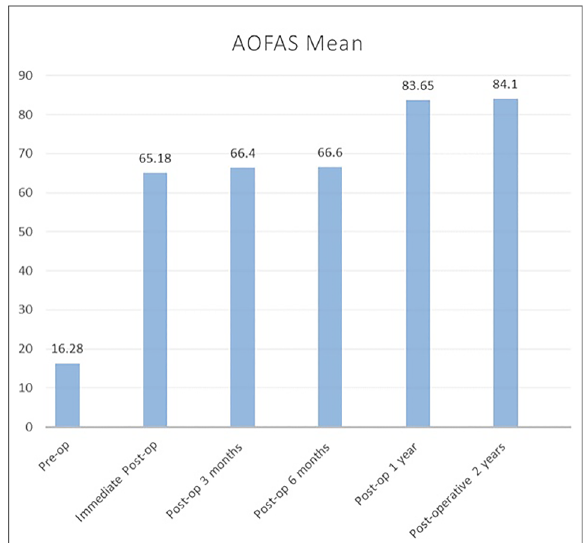
FIGURE 3 AOFAS mean score for 2 years follow-up. AOFAS, American Orthopaedic Foot & Ankle Society.